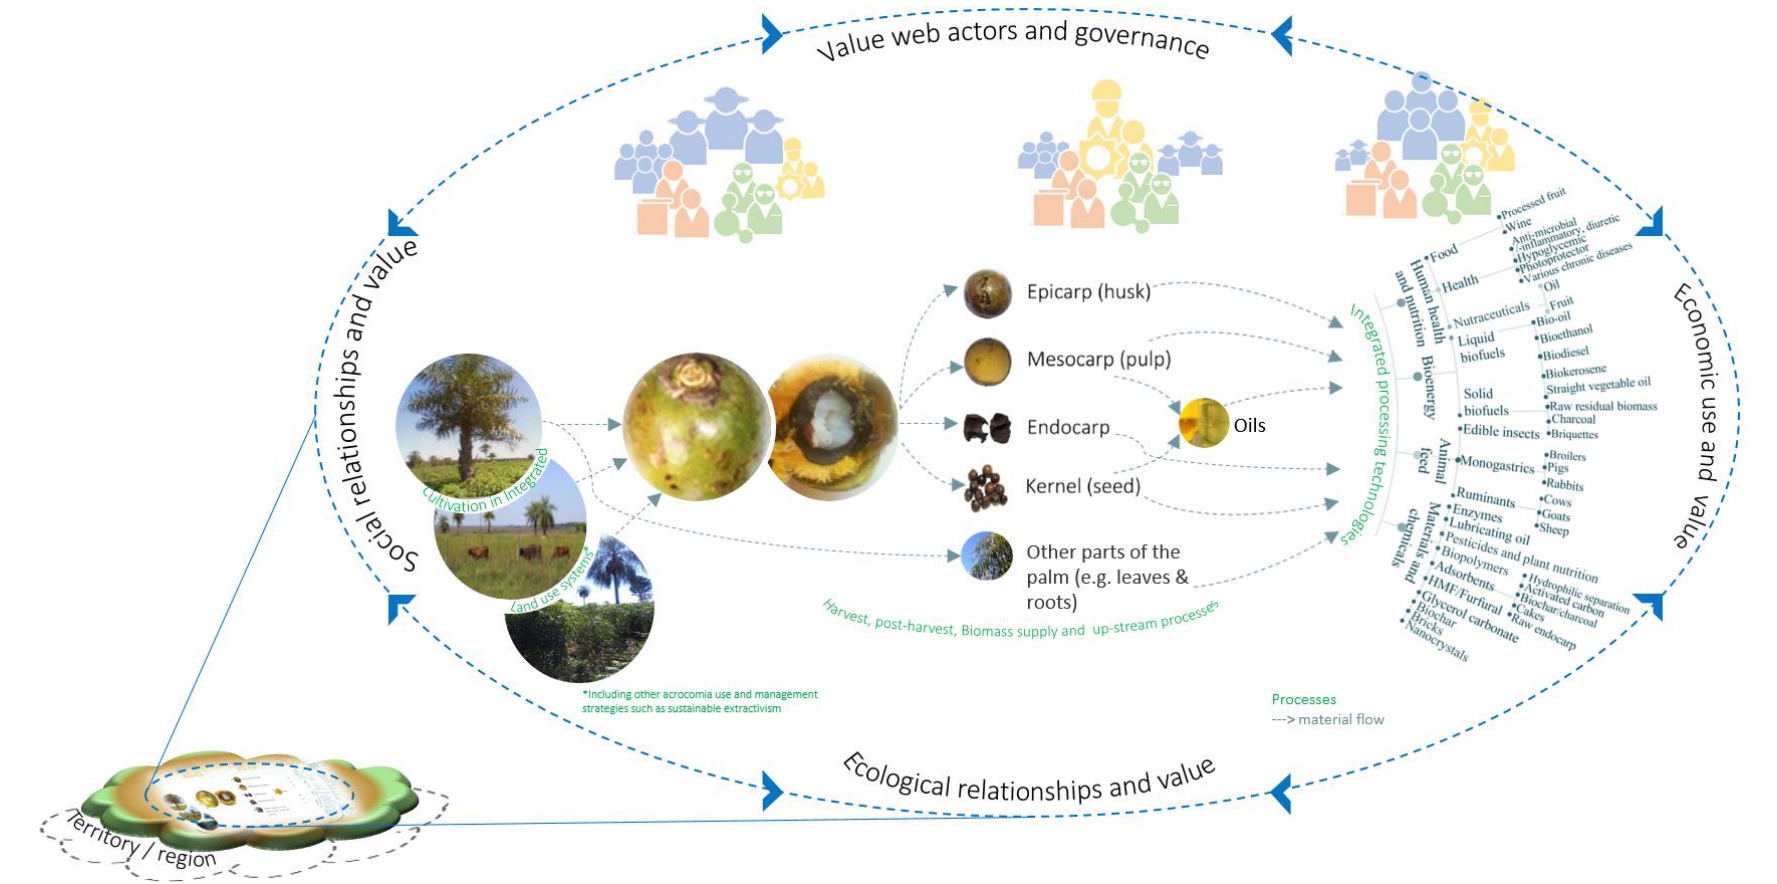
Figure 4. Conceptual acrocomia value web, territorially embedded. It displays: (1) the actors — farmers ; civil society: ; industry and business associations: ; government: ; research organizations: — involved and their relative importance (icon size) along the value web; (2) the material flows, from biomass production, through processing to a range of investigated applications using oils, fruit fractions and by-products; and (3) context factors that influence and interrelate with the value web system. The dotted boundary lines represent the openness of the system in terms of flows (material, information, funding, knowledge), relationships with external systems (biophysical, social, economic), and actors. Adapted from [6,130].